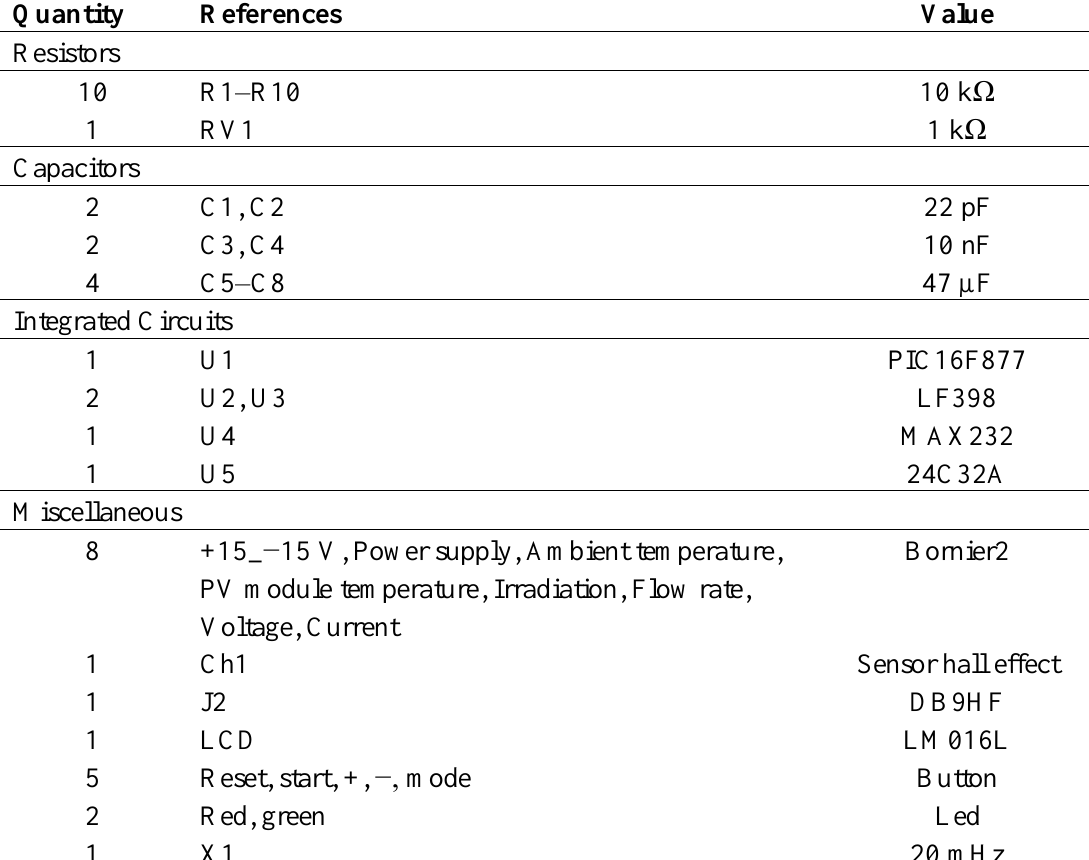
Table 1. The electronic circuits components of the data